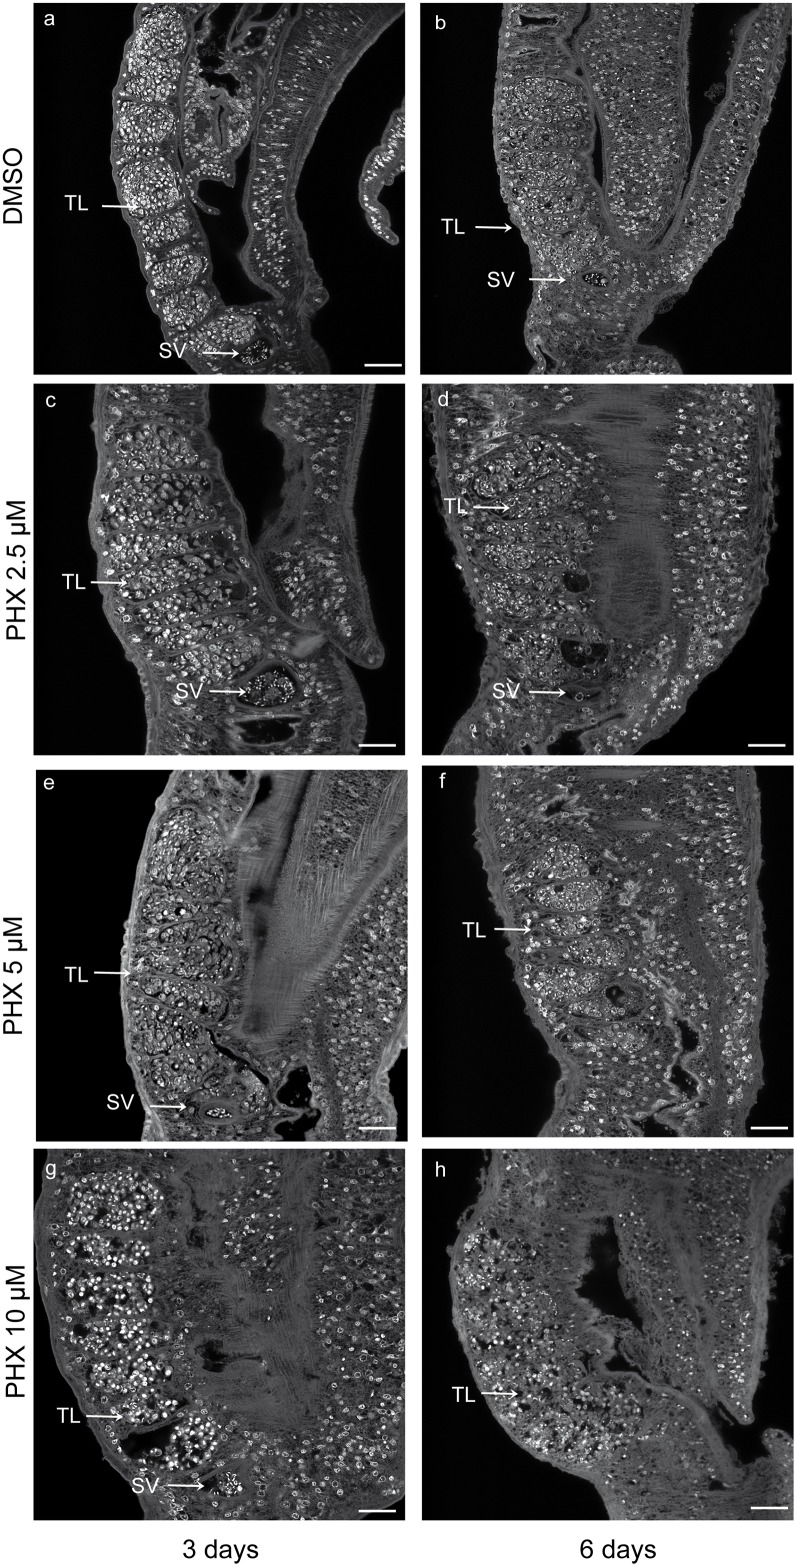
Testis alterations in adult male worms treated with PHX—Confocal microscopy analysis.Representative confocal laser scanning microscope images of adult male testes. S. mansoni worm couples were treated with DMSO (a, b) or different doses of PHX (c-h) for 3 and 6 days and stained with carmine red. Testicular lobes (TL) and sperm vesicle (SV) are indicated. Scale bars = 50 μm (a-b) and 25 μm in all PHX treated samples (c-h).